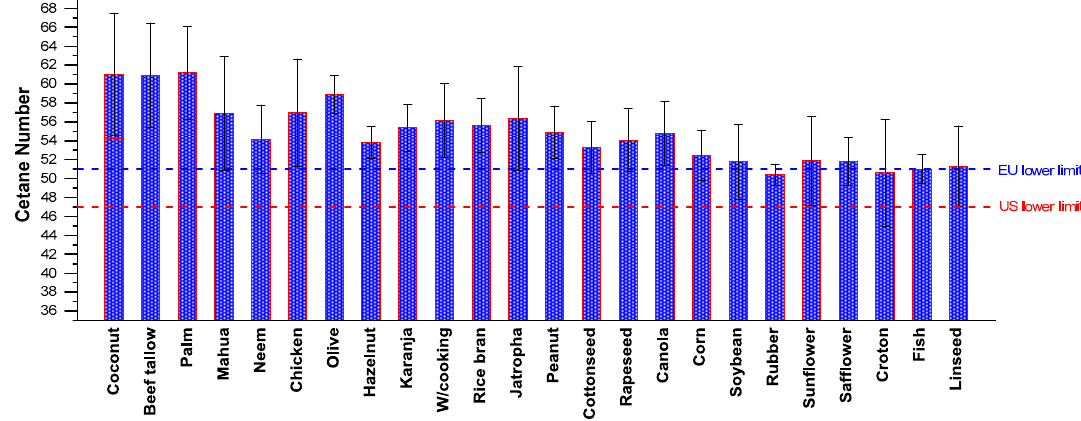
Figure 1. Average cetane numbers of biodiesels from various feedstocks; the EU and US lower limits correspond to automotive applications (reprinted from [6] with permission from Elsevier). Energies 2019 , 12 , x FOR PEER REVIEW